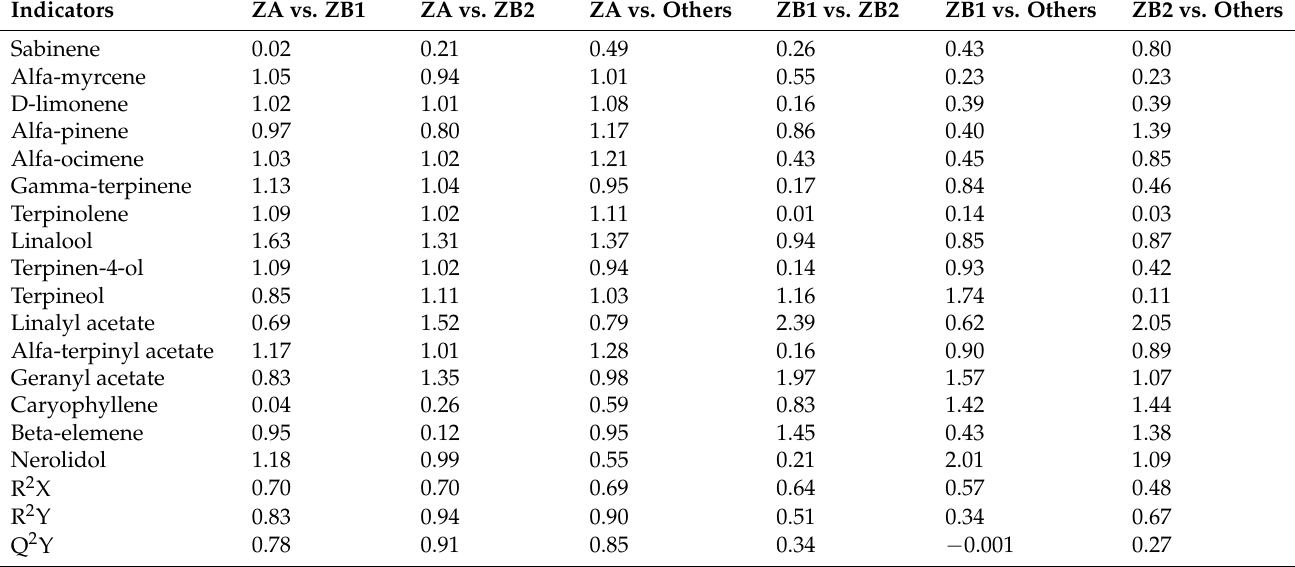
Table 2. Variables important in projection and verification by permutation test between different prickly ash